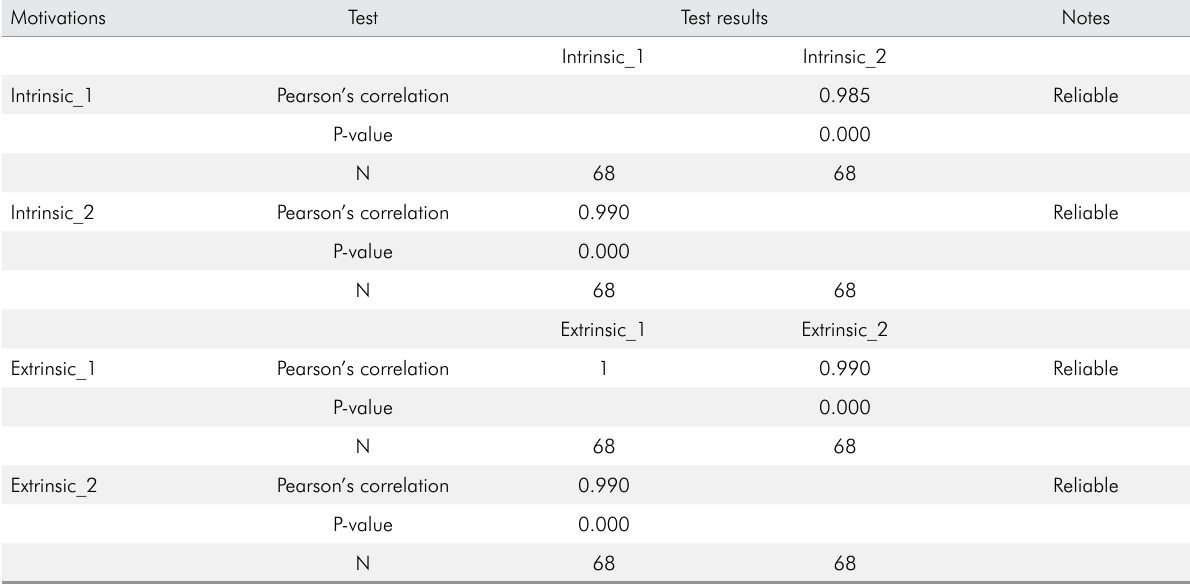
Table 8. Test-retest results for the modified DTMS